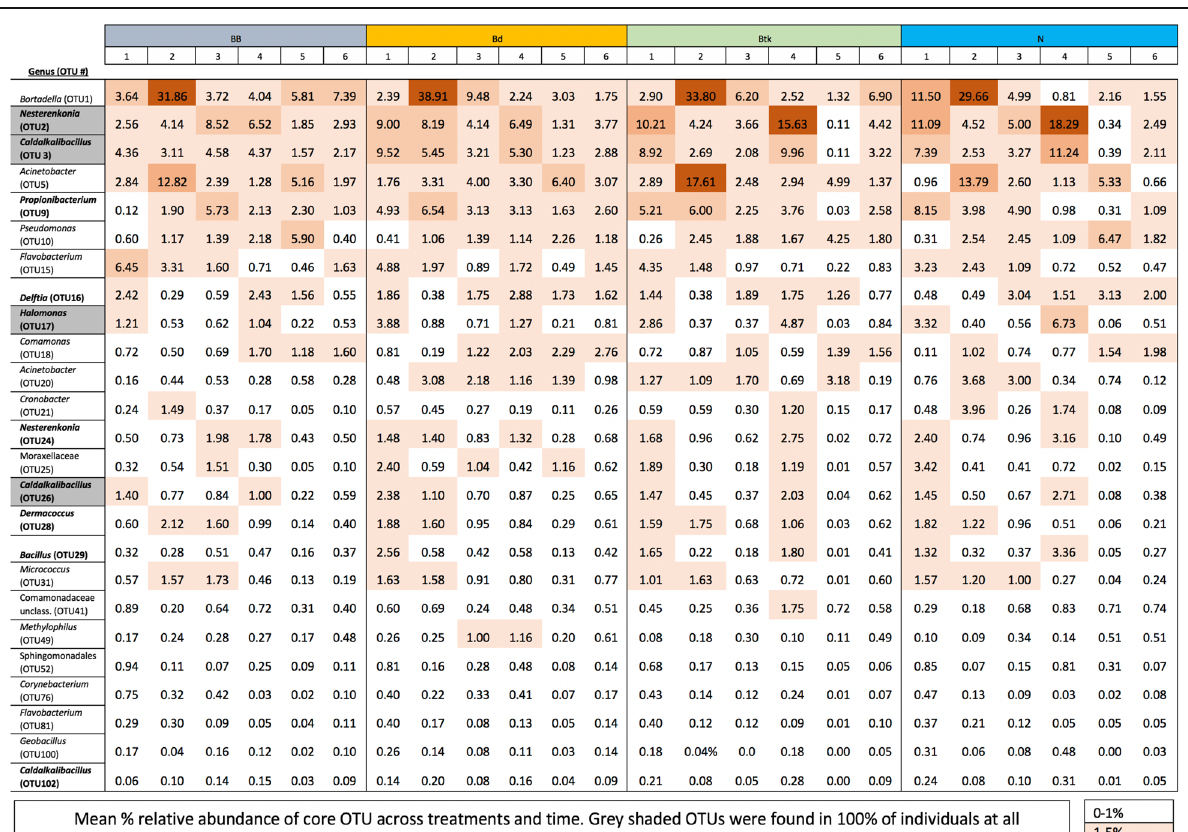
Fig. 4 Mean % relative abundance of core OTU across treatments and time. Grey shaded OTUs were found in 100% of individuals at all time points. Bolded OTUs were significant for treatment x time interaction. Timepoints 1 – 6 correspond to treatment times (timeline: Fig. 1) as follows: (1) pre-application, (2) 48 h post-Btk, (3) 6 d post-Btk, (4) 10 d post-Btk, (5) 1 week post-Bd, (6) 2 weeks